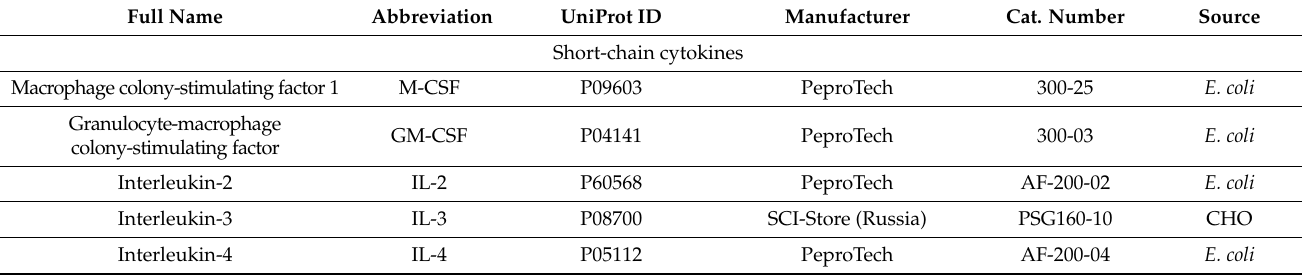
Table 2. The four-helical cytokine samples studied in the present work with regard to their affinity to Ca 2+ -bound